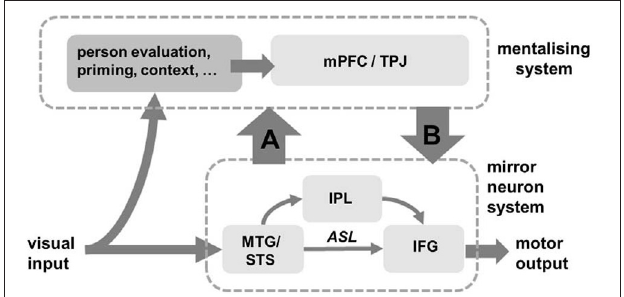
FIGURE 3 | Three brain models for information processing during mimicry. Mimicry is implemented in mirror neuron system (lower half) and developed by associative sequence learning (ASL), but it is not clear how this system interact with mentalising system (top half). When mimicry information feeds up to aid social evaluation (arrow A), this enhances simulation of the other person (“the simulation model”). Social top-down response modulation (STORM) model is illustrated by arrow B, showing how social information can guide and monitor mimicry response. When there is no interaction between mirror neuron system and mentalising system, the control of mimicry could be mediated by other domain-general processes (“the domain-general